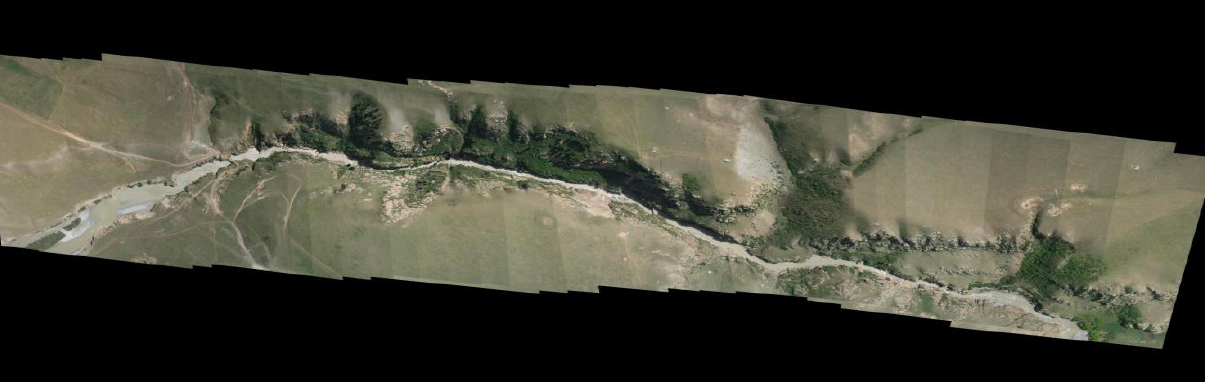
Figure 4. 36 pieces of images stitched together